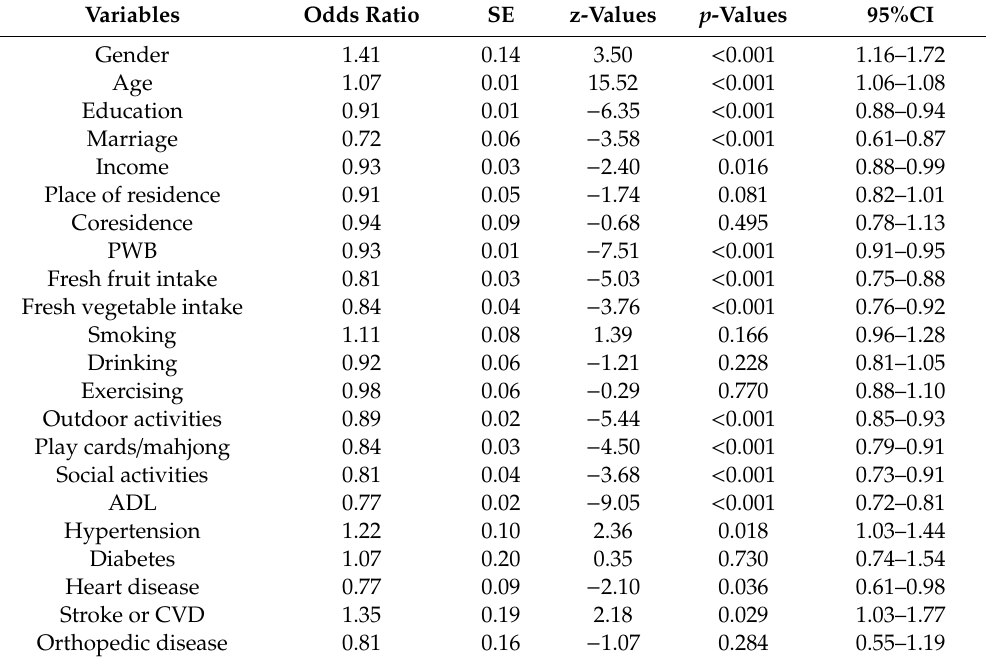
Table 5. Binary logistic regression analysis of risk factors for cognitive impairment in the